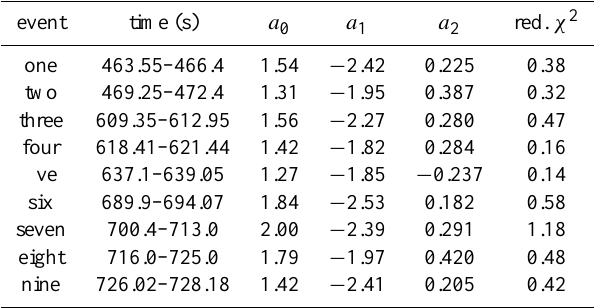
Table 1. Fit parameters for all nine events, as described in the text.